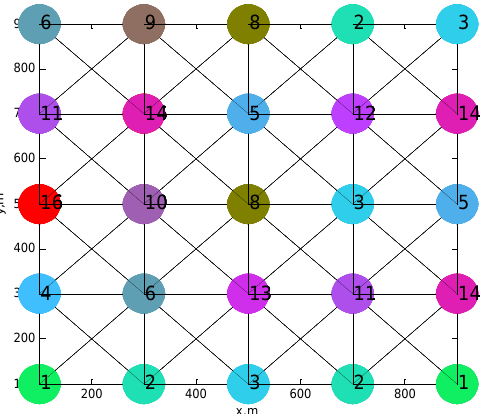
Figure 7. Simulation network topology.